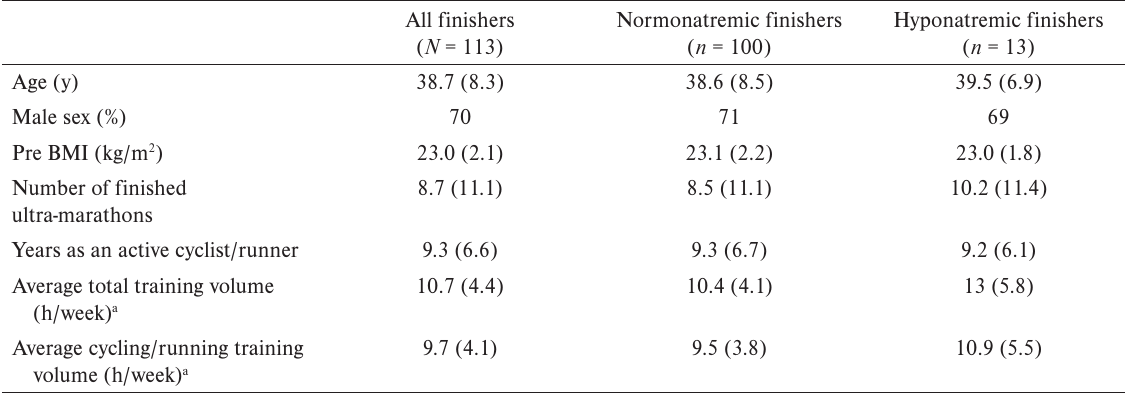
Pre-race characteristics of the athletes who underwent blood measurements. Data are reported as mean (SD) except where indicated to be a